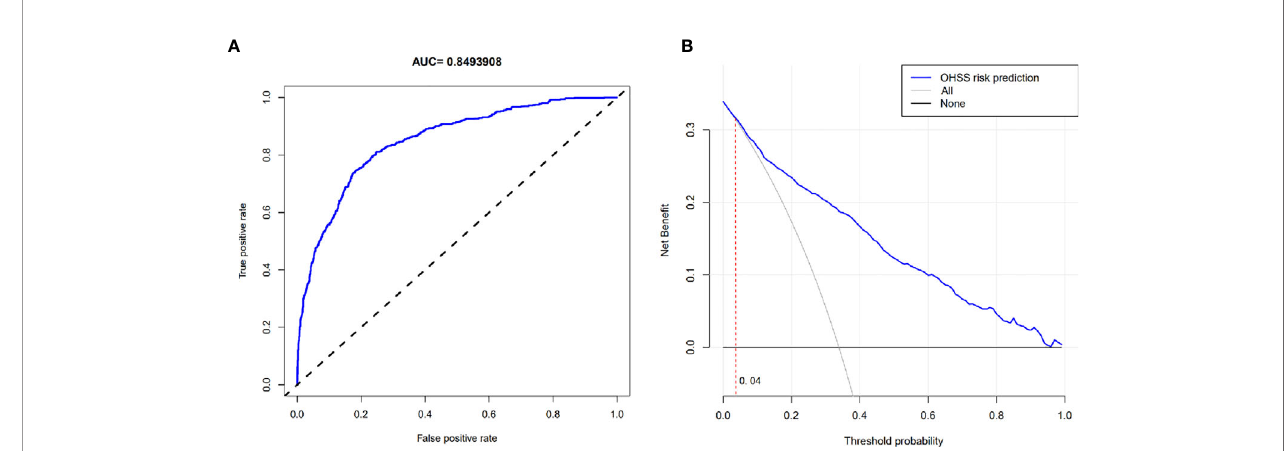
FIGURE 3 | (A) ROC curve. (B) Decision curve analysis. (B) The horizontal solid line represents the clinical net bene fi t when none patients are treated after oocyte retrieval, the backslash with a negative grey slope represents the net bene fi t when all patients are treated. When the blue curve was above the part of the two extreme curves where the threshold probability was >4%, using this nomogram in the current study to predict OHSS risk gets more clinical bene fi